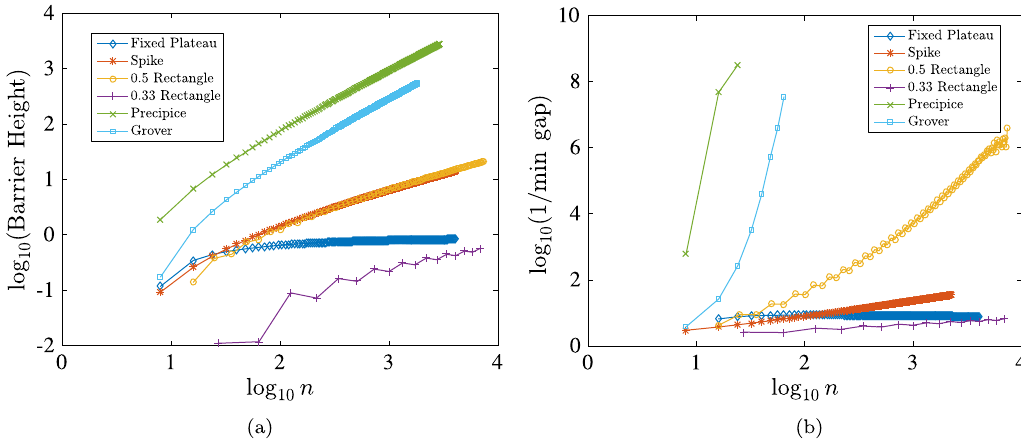
FIG. 4. (a) The height of the barrier between the two wells at the degeneracy point of the spin-coherent potential [as seen in Fig. 2(a)], as a function of n for the fixed plateau, the spike, the 0.5-rectangle, the 0.33-rectangle, the precipice, and Grover problems (log-log scale). (b) The inverse of the minimum gap as a function of n for the fixed plateau, the spike, the 0.5-rectangle, the 0.33-rectangle, the precipice, and Grover problems (log-log scale). The important thing to note is that the order of scaling is preserved in both plots; that is, the steeper the scaling of the barrier height, the steeper the scaling of the inverse minimum